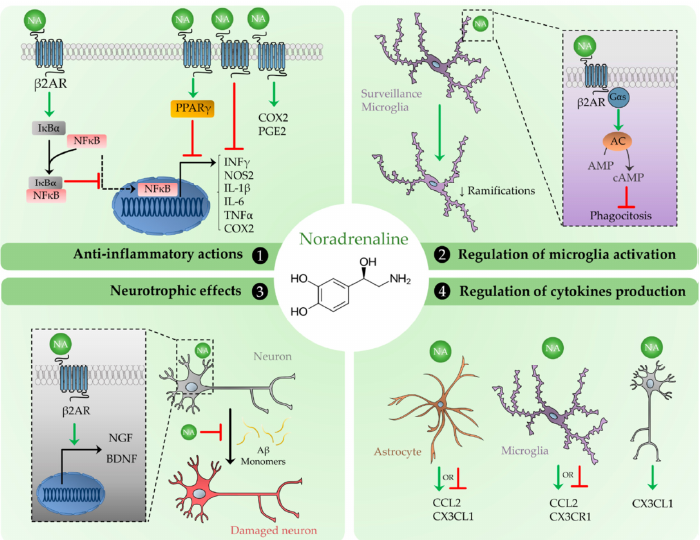
Figure 2. Neuroprotective actions of noradrenaline.